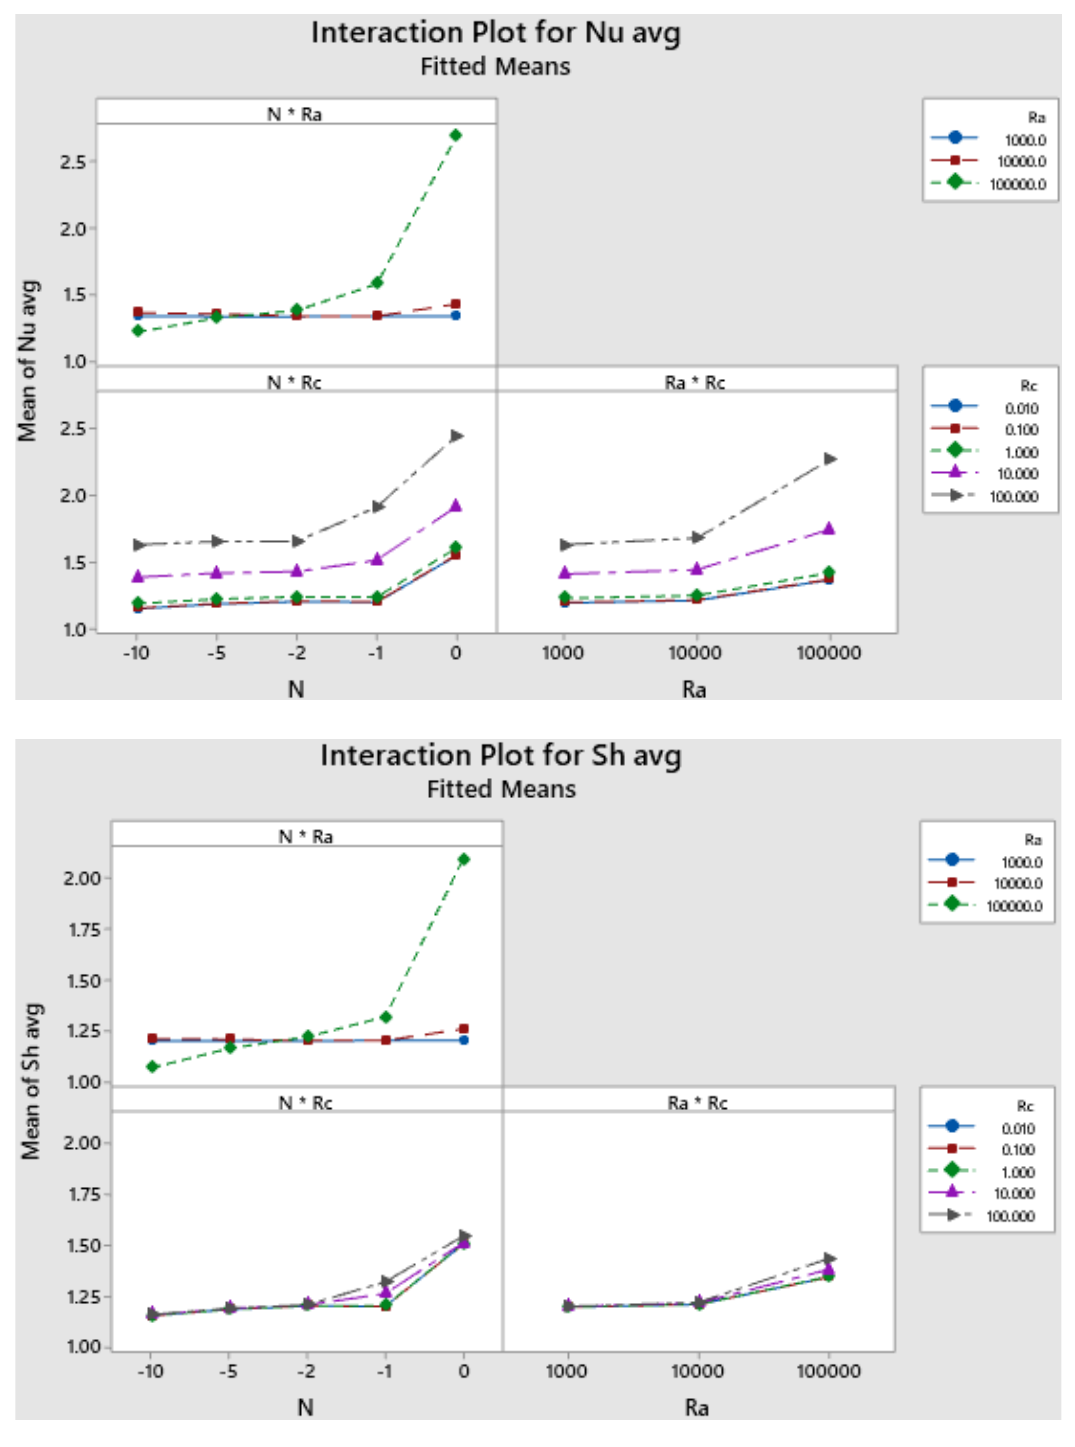
Figure 10. Interaction plots for Nusselt and Sherwood average. The regression model is carried on and the following equations are determined us- ing